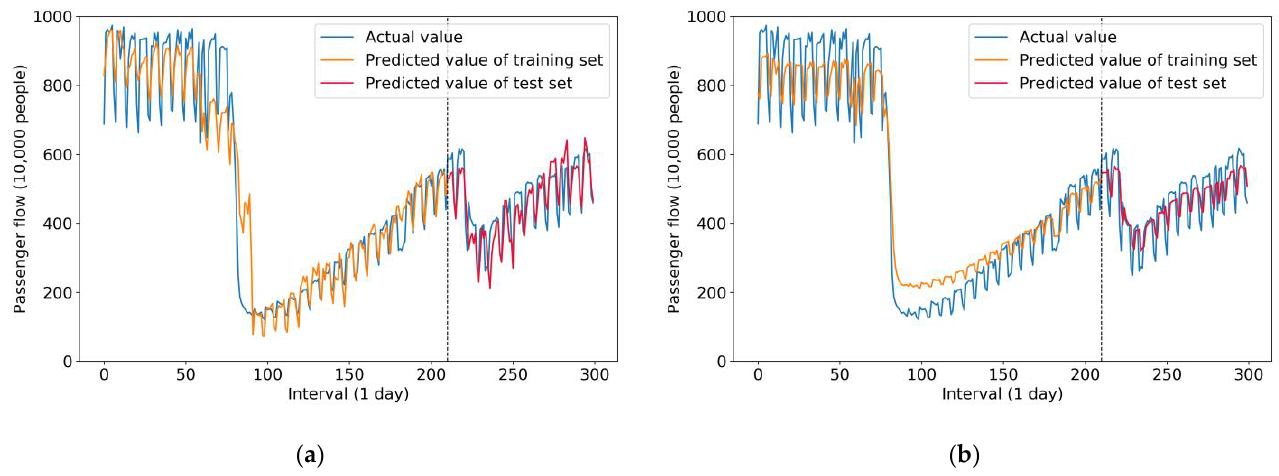
Figure 7. Comparison results of the predicted value and the actual value in two hybrid models: ( a ) comparison results of the ISTL-LSTM model; ( b ) comparison results of the STL-LSTM model.